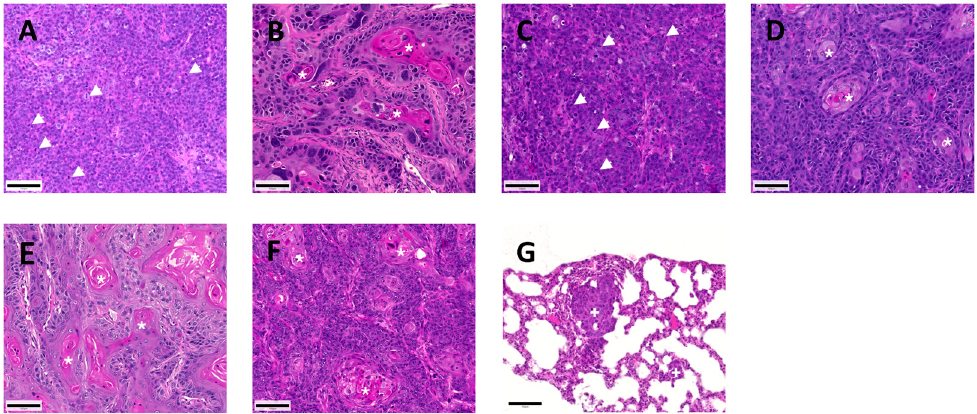
Figure 4. Hematoxylin-eosin (HE)-stained primary tumors and lung metastases of HNSCC cells grown in severe combined immunodeficient (SCID) mice. Note the poorly differentiated UTSCC 2 ( A ) and 24A ( C ) tumors with numerous mitoses ( ) and immature cells, whereas UTSCC 16A ( B ), 24B ( D ), 60A ( E ), and Carey 24 ( F ) primary tumors were more differentiated with keratin pearl formation ( ). Only UTSCC 24A cells produced histologically detectable lung metastases ( G , ). Scale bar: 100 µm.